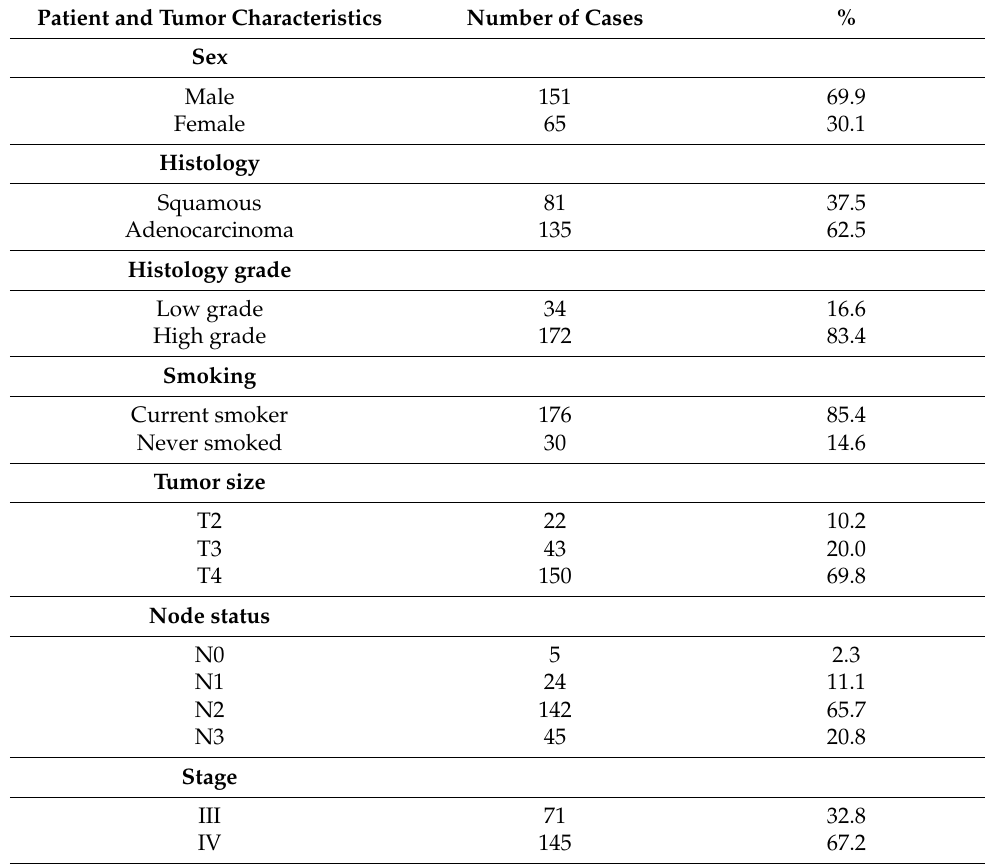
Table 1. Baseline Characteristics of the Study Population of Advance NSCLC